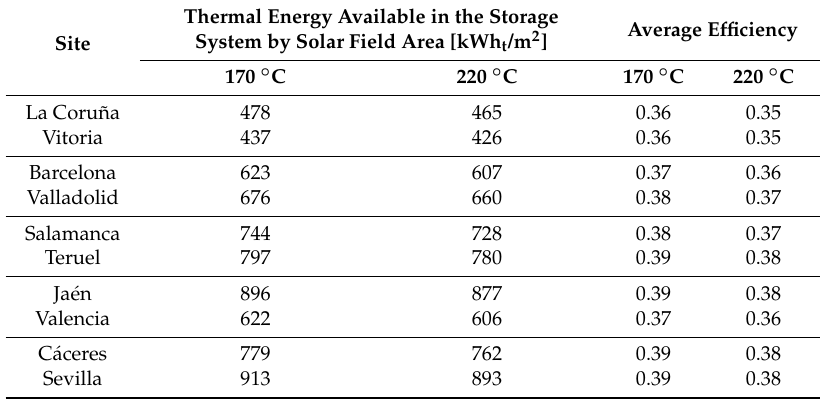
Table 19. Thermal energy available per solar field area and average efficiency for each site and thermal level, LFC technology.